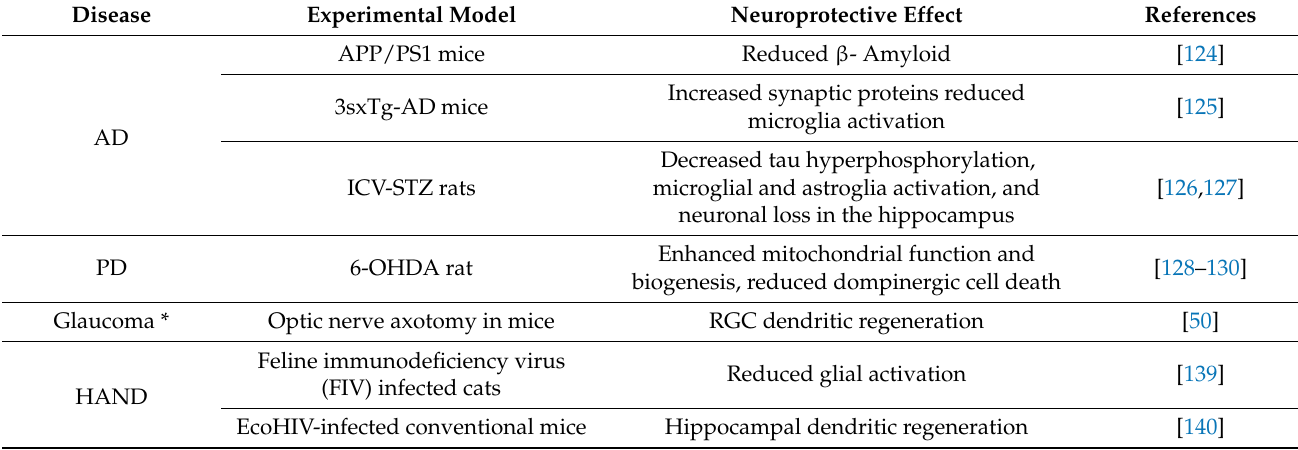
Table 1. Neuroprotective effects of exogenous insulin administration in experimental models of neurodegenerative diseases. Disease Experimental